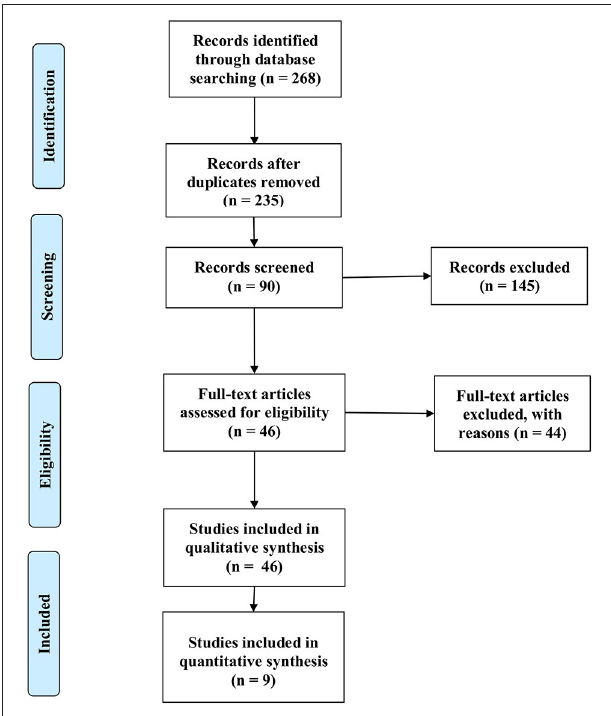
FIGURE 1 | Flow of identification, screening, and eligibility of articles in this systematic review. From Moher et al., 2009a